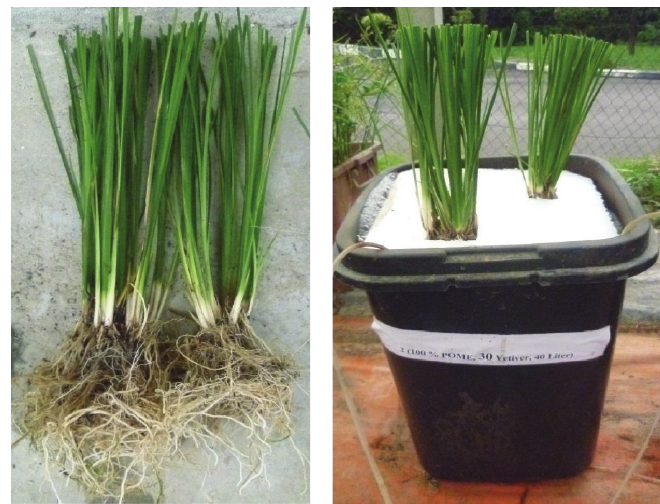
Figure 3: Vetivers after five weeks ready for experimentation.